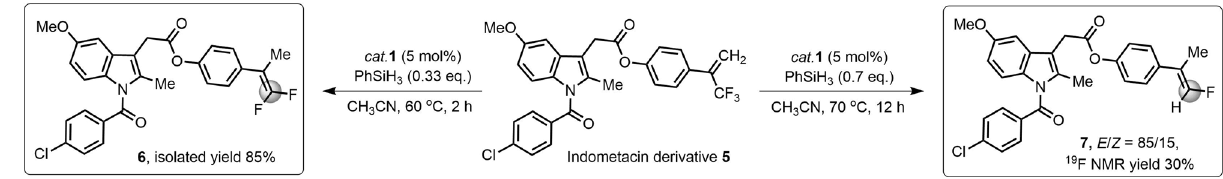
Fig. 6 Modi fi cation of the drug molecule. E / Z ratios were determined by 19 F NMR spectroscopy.